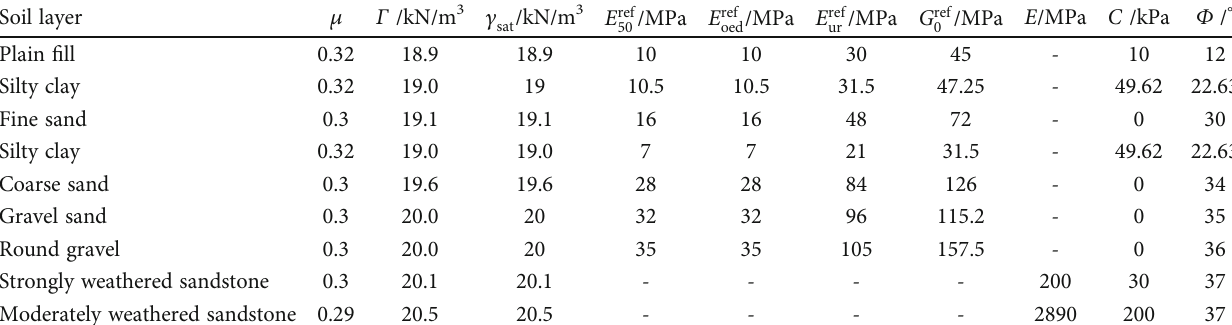
Table 2: Soil layer parameters.